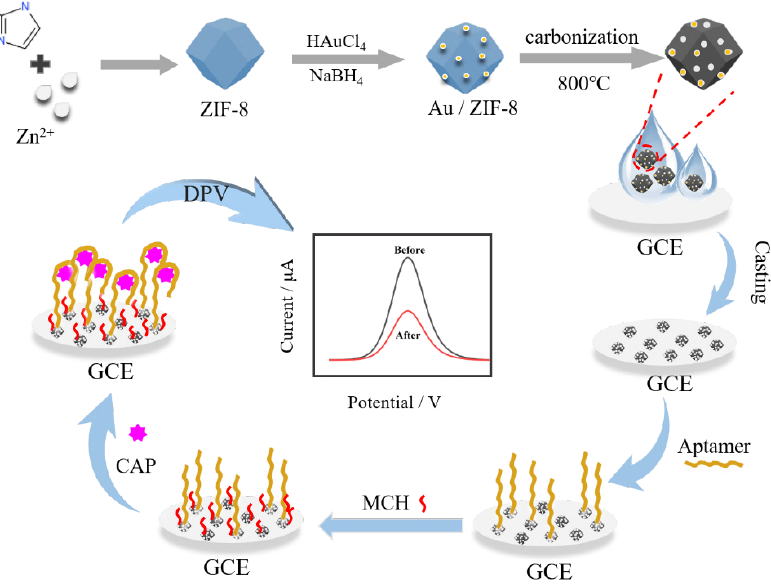
Scheme 1. Schematic diagrams of fabricating the designed electrochemical aptasensor based on AuNPs/PCs for CAP